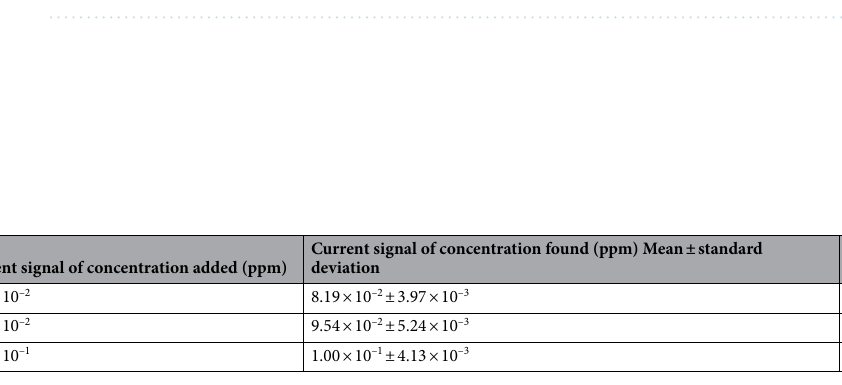
Table 5. The comparison of the modifications used for determining Zn 2+ in drinking water.